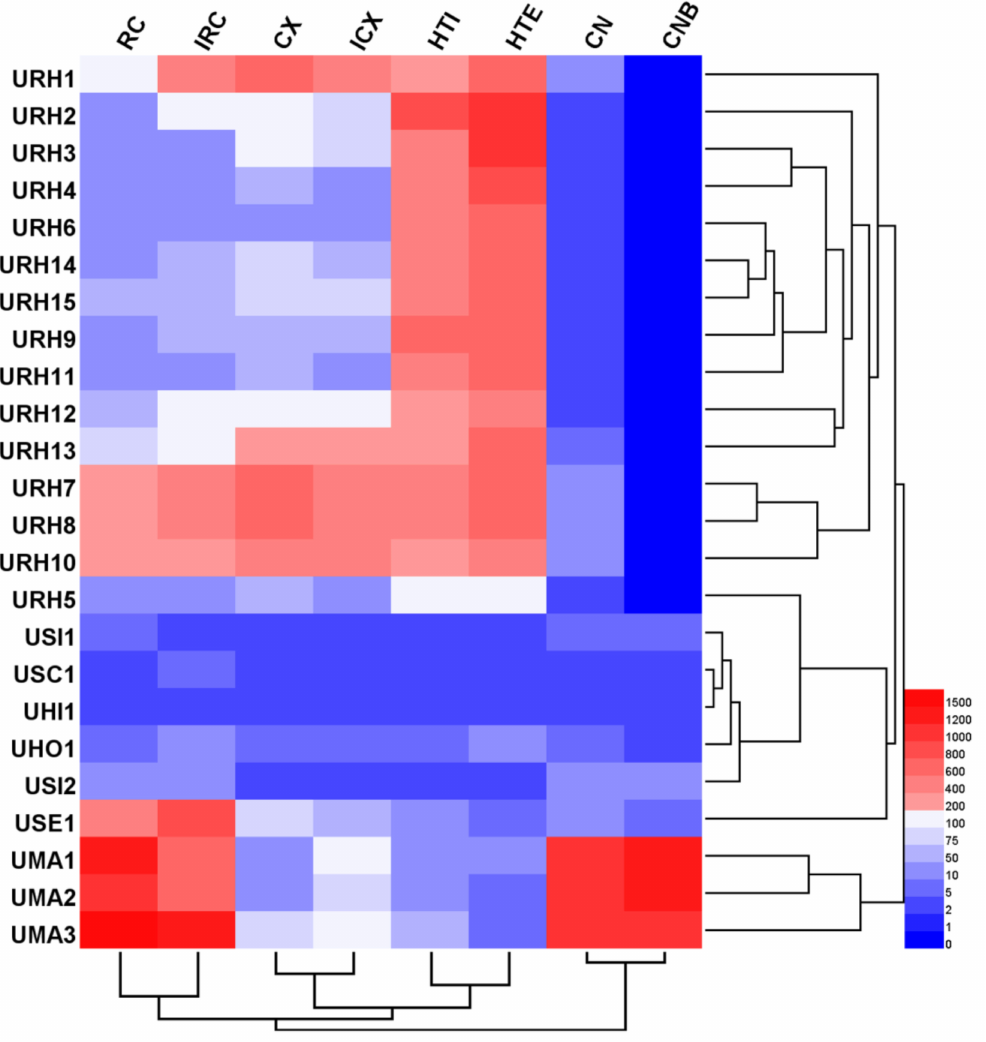
Figure 3. Hierarchical clustering analysis of Uncaria